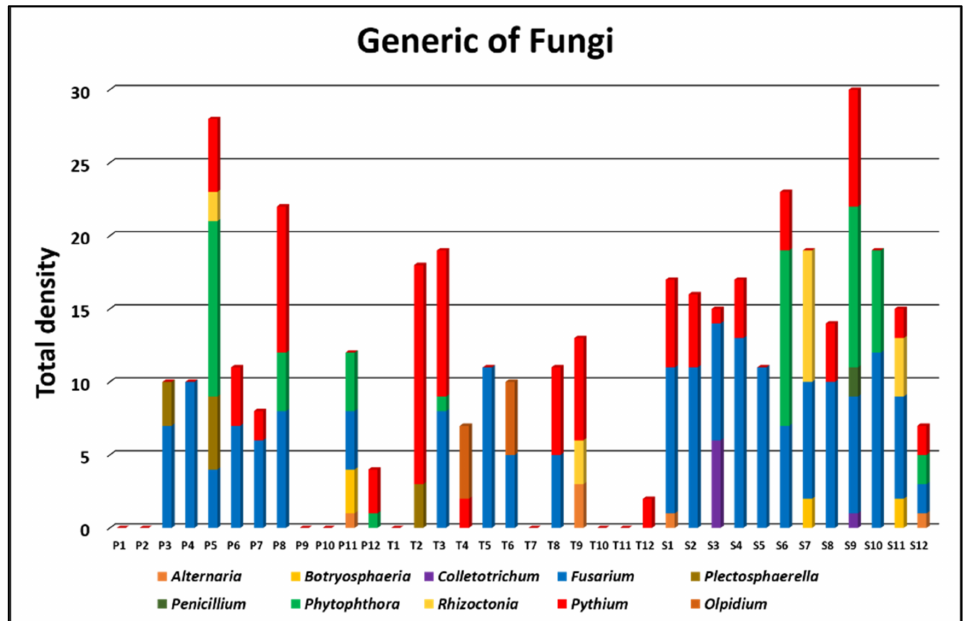
Figure 3. Total density of fungi detected at 36 study sites according to generic division; P: paprika, T: tomato, S: